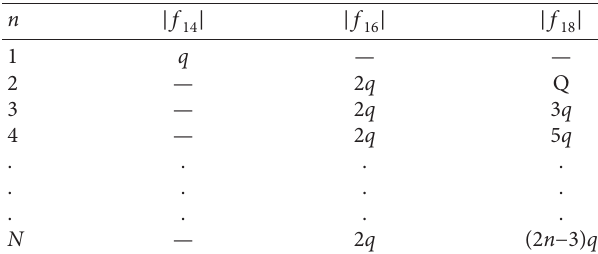
with given number of